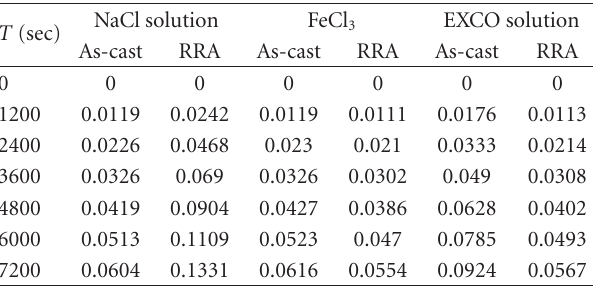
Table 15: Electrochemical corrosion rate for the control